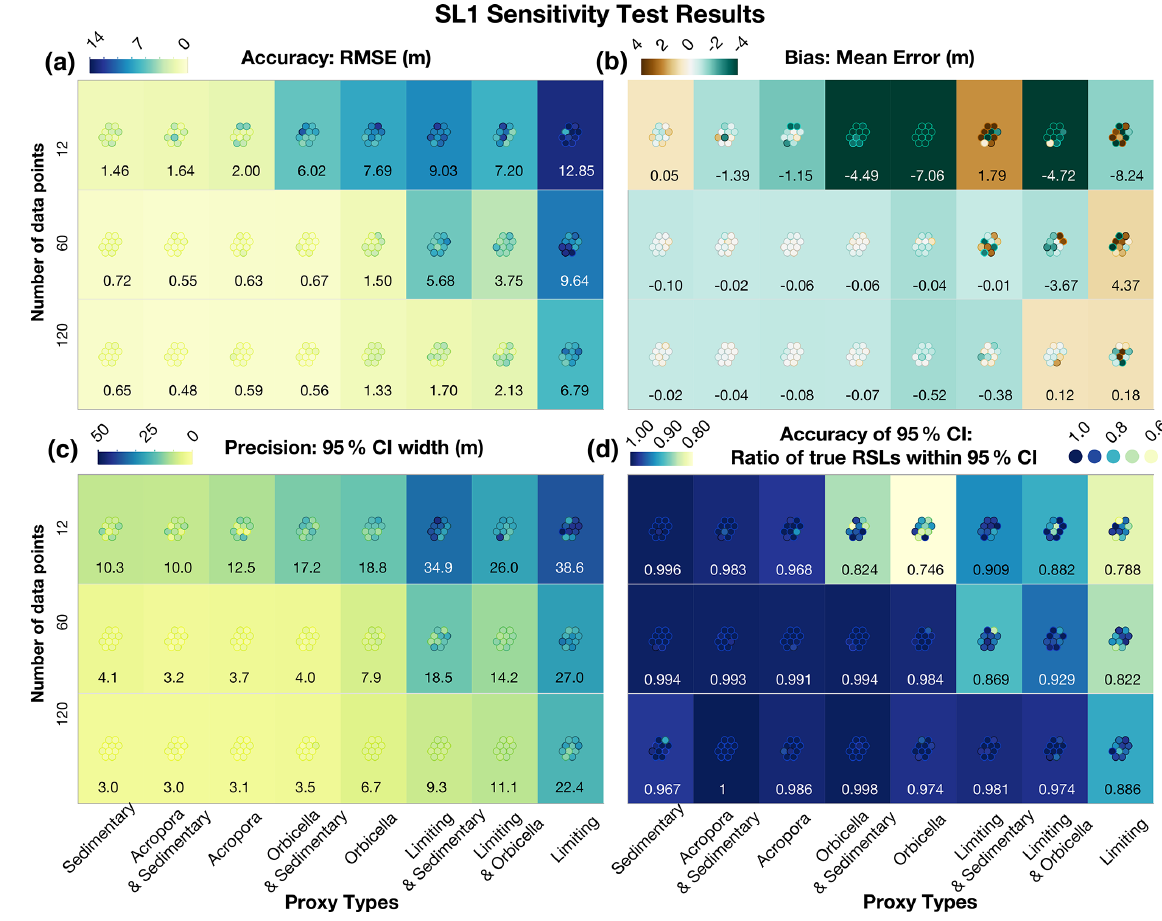
Figure 9. SL1 sensitivity test results. The quantity of data is shown on the left, and the type of proxy is displayed on the bottom of each panel. The numbers in the boxes represent the cross-model averages of each metric, and the circles represent each of the individual tests. The specific values of these individual metrics are shown in Table D5. (a) Accuracy is represented by the root-mean-square error (RMSE), where blue values indicate less accuracy; (b) bias is represented by the mean error, where green is negative bias and brown is positive bias; (c) precision is measured by the width of the 95% credible interval (CI), where blue signifies the least precise model runs; and (d) accuracy of the uncertainty intervals (or coverage %) is measured by the ratio of true values within the 95%CI, where blue represents the highest coverage or greatest accuracy (Table